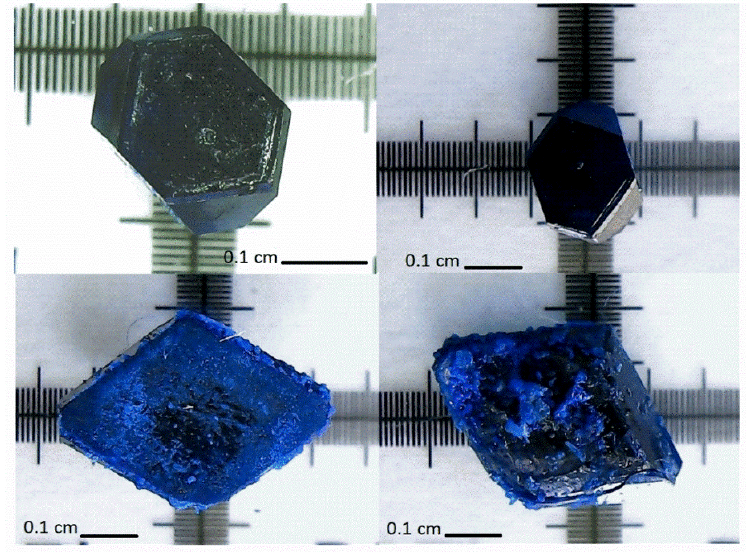
Figure 7. View of crystals with UV assistance by digital microscopy.